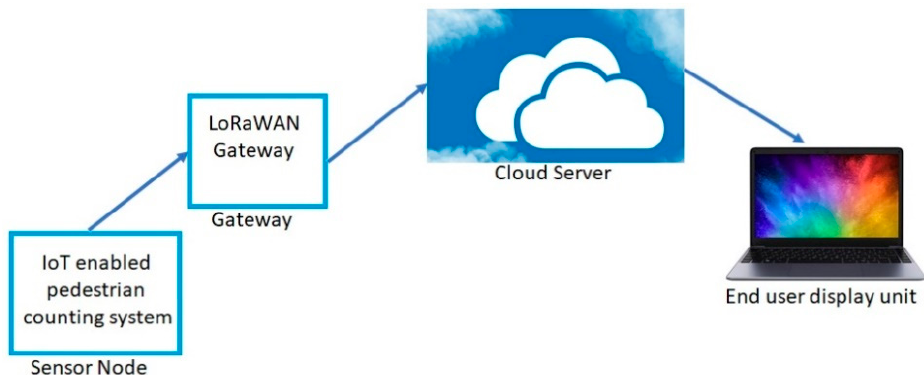
Figure 9. Block diagram of the Lora based pedestrian counting system.